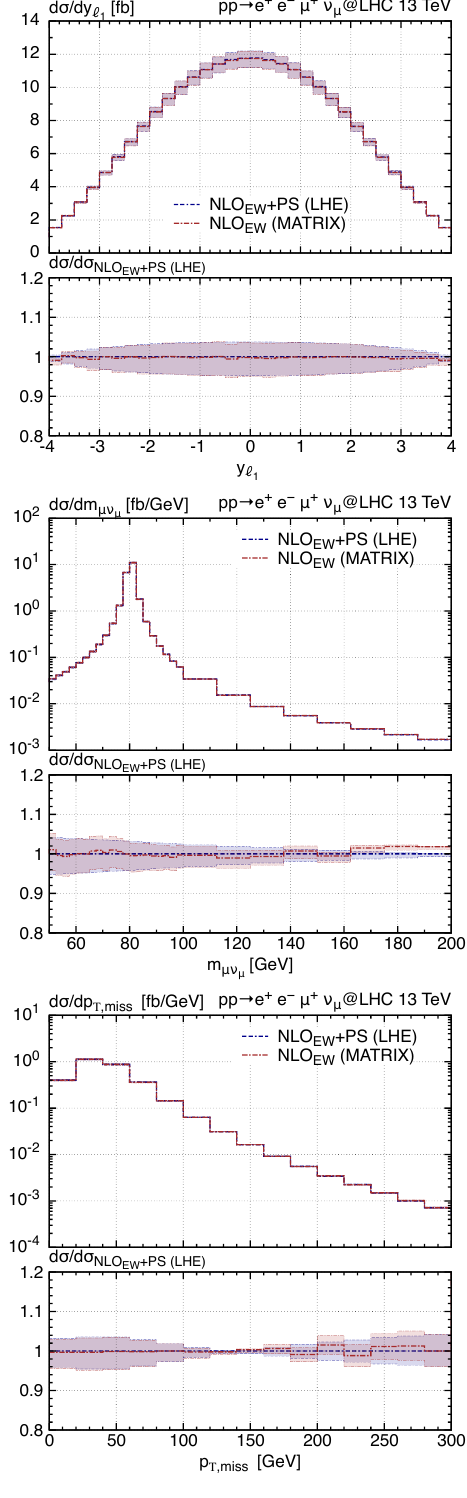
Figure 3. Comparison of NLO EW +PS (dark blue, double-dash dotted) and fixed-order NLO EW (brown, dash-dotted) predictions for W + Z production in the inclusive setup